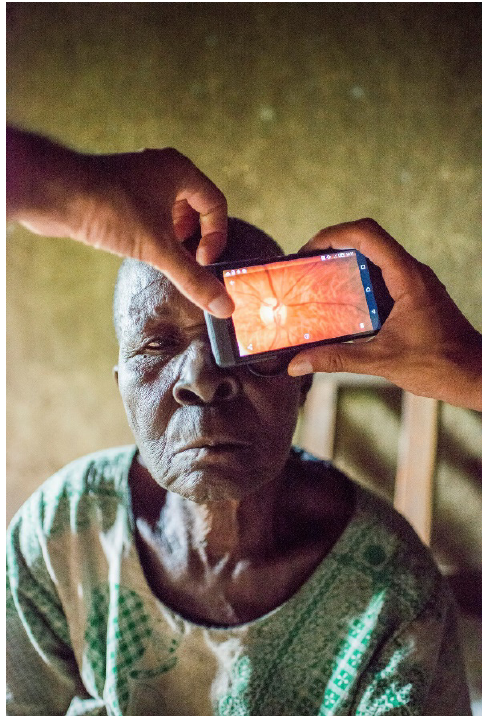
Fig. 1. \Laureate Andrew Bastawrous uses the Peek device to examine a Kenyan woman su®ering from blindness. ... British eye surgeon and public health doctor, Andrew Bastawrous has pioneered a brilliant solution (cid:1)(cid:1)(cid:1) a portable eye test kit that operates by mobile phone and can be used by ordinary people to screen for common eye diseases. His Portable Eye Examination Kit (Peek) enables non-medical users to test visual acuity, scan for disease and transmit the results to trained ophthalmologists in distant hospitals for rapid diagnosis and follow-up treatment. Following successful trials, Peek is now being used in Kenya, Botswana, Tanzania, Ethiopia and India with many other regions and countries planned for extended access to eye care. He will also set up a centre of excellence in Kenya to provide training and foster collaboration." Photo from Rolex web-site 1 ° c Rolex/Joan Bardeletti (journal articles of the respective study are Bastawrous et al. 2,3